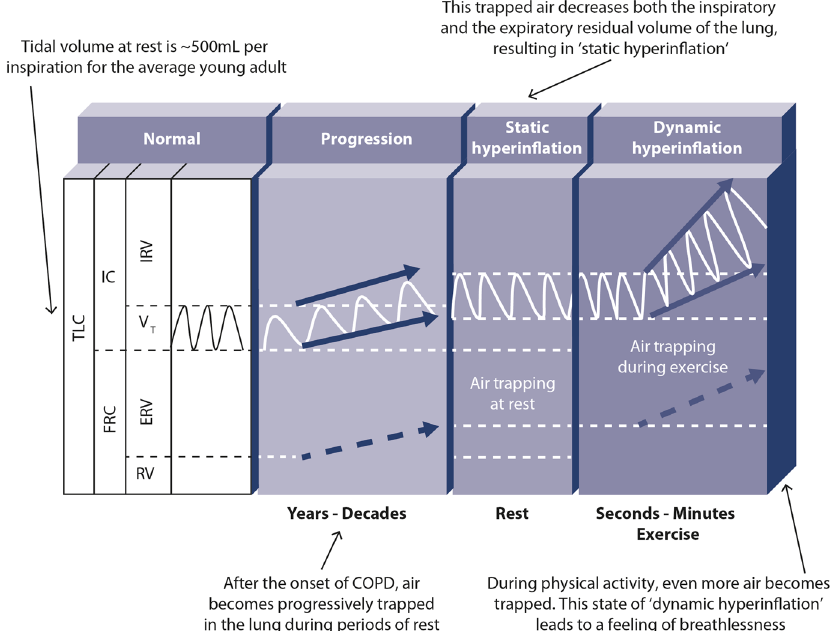
Fig. 1 Relationship between hyperin fl ation and breathlessness in patients with COPD. ERV expiratory reserve volume, FRC functional residual capacity, IC inspiratory capacity, IRV inspiratory reserve volume, RV residual volume, TLC total lung capacity, V T tidal